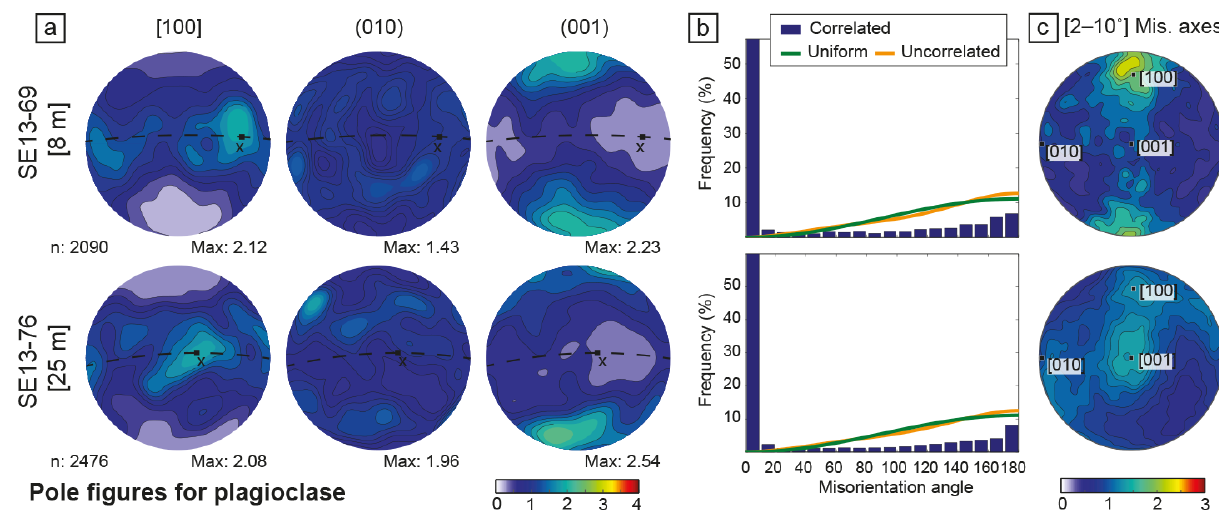
Figure 12. (a) Pole figures illustrating CPO of plagioclase in samples from the HTa unit of Sumeini; (b) distribution of misorientation angles; (c) inverse pole figures showing the distribution of correlated misorientation axes (between 2 and 10 ◦ ). See caption of Fig. 7 for